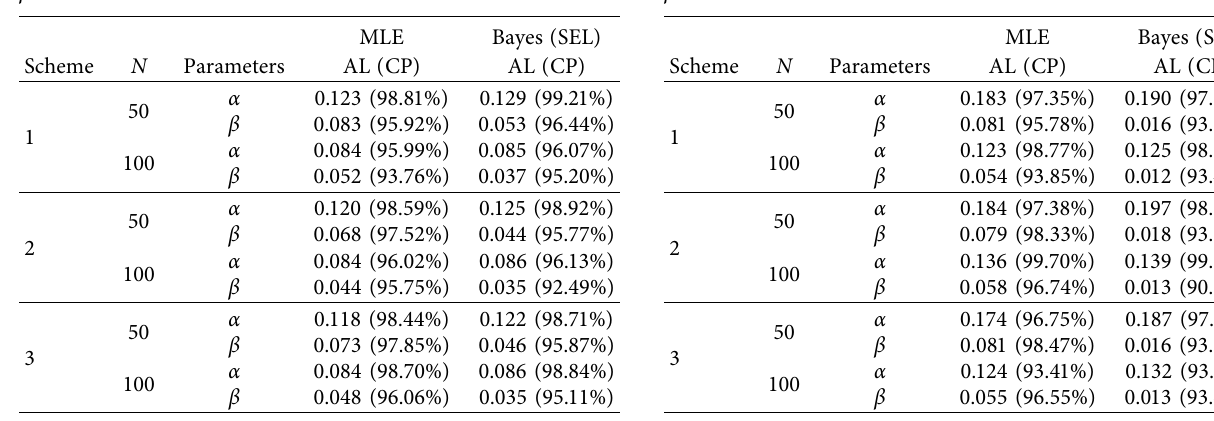
Table 3: Average lengths and coverage percentages for 95% asymptotic and credible CI based on PT2CS, with α � 0 . 5 and β � 0 . 5.